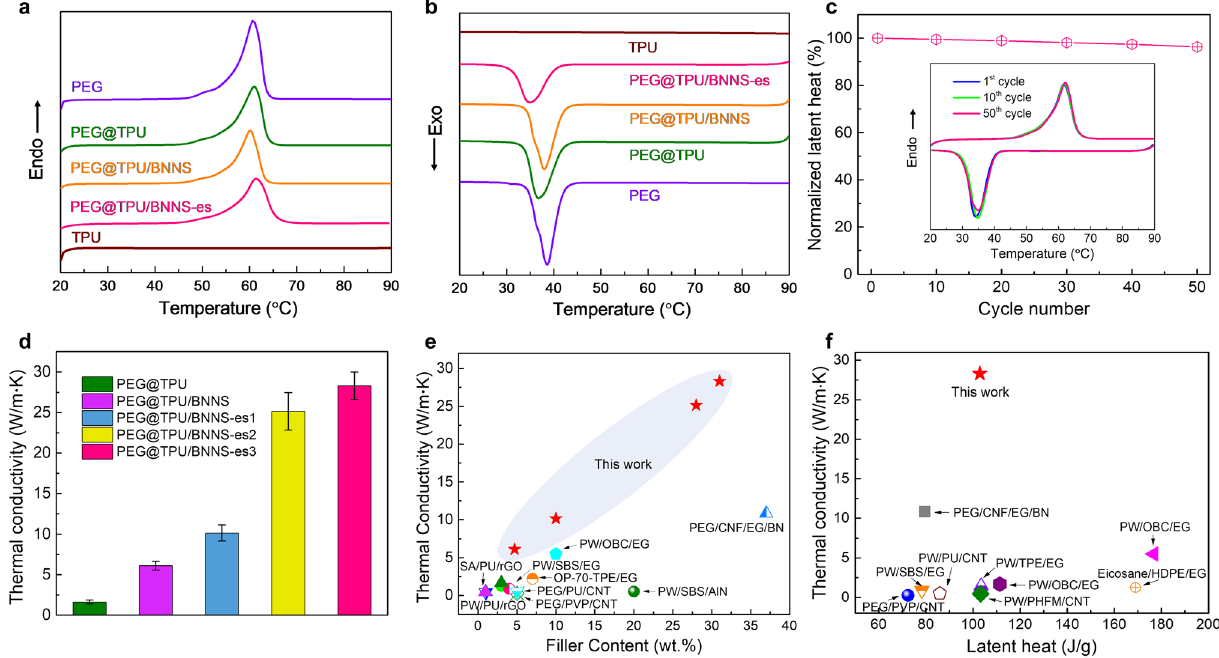
Fig. 3 Thermal properties of various materials. DSC curves of the materials during a heating and b cooling. c Normalized latent heat of fusion for PEG@TPU/BNNS-es with ~ 32 wt% BNNSs, the inset shows the DSC curves for 1st, 10th and 50th thermal cycles of PEG@TPU/BNNS- es. d In-plane thermal conductivity of various PCCs studied in this work, PEG@TPU/BNNS-es 1–3 have a BNNS loading of about 10, 28 and 32 wt%, respectively. e Thermal conductivity versus filler loading of PEG@TPU/BNNS-es and reported PCCs with filler loading < 40 wt% [32, 33, 39–47]. f Thermal conductivity versus latent heat of PEG@TPU/BNNS-es and reported flexible PCCs [32, 33,